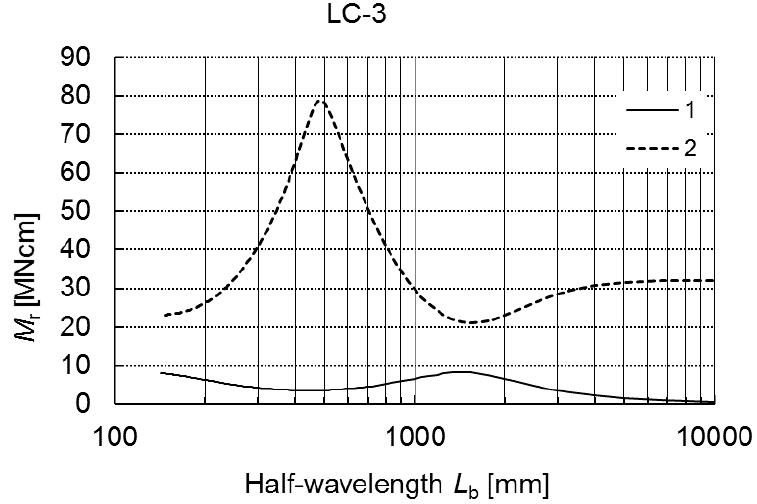
Figure 11. Buckling moments M r as a function of the buckling half-wavelength L b for LC-3.